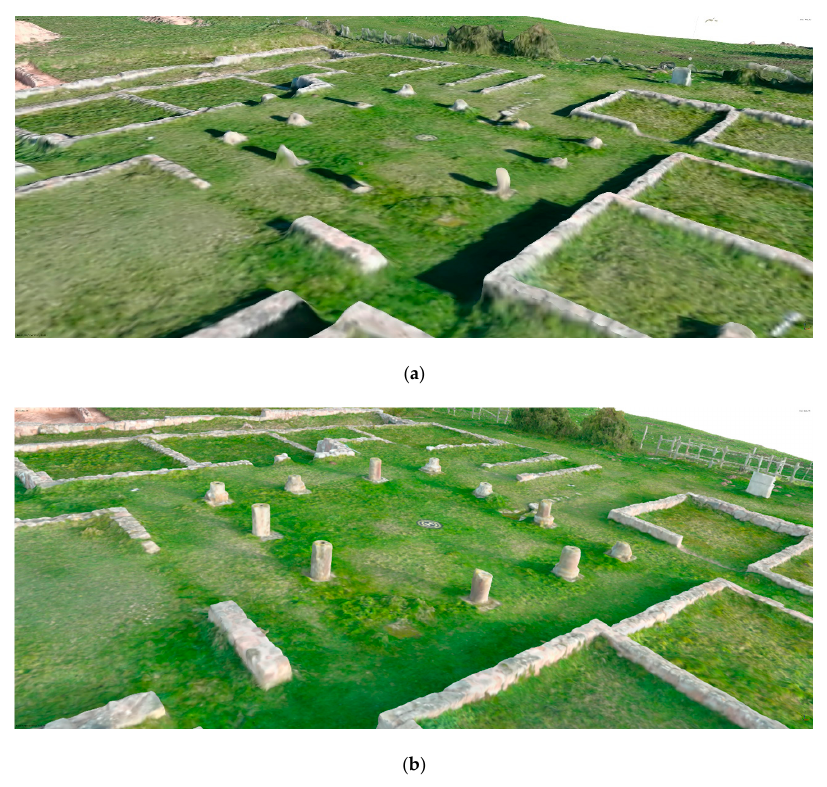
Figure 8. Graphic outputs obtained from the most accurate flight. ( a ) Texturized model. ( b ) Ortho- photograph. ( c ) Interactive PDF. ( d ) Virtual itinerary.